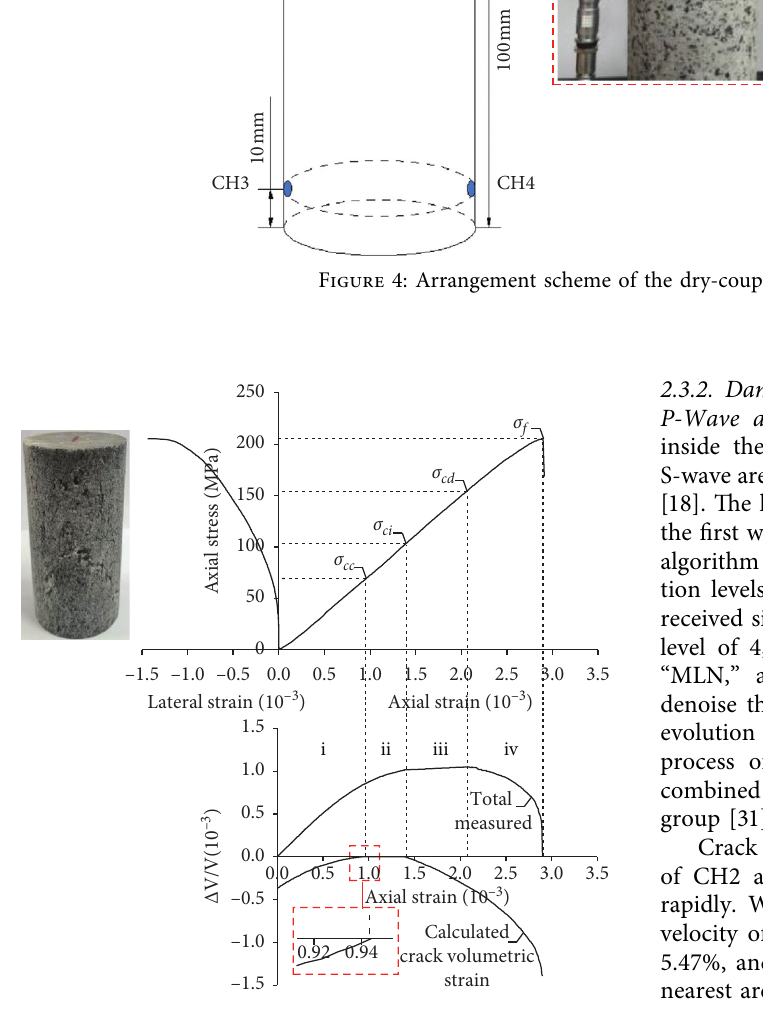
Figure 5: Stress–strain of granite under uniaxial loading.